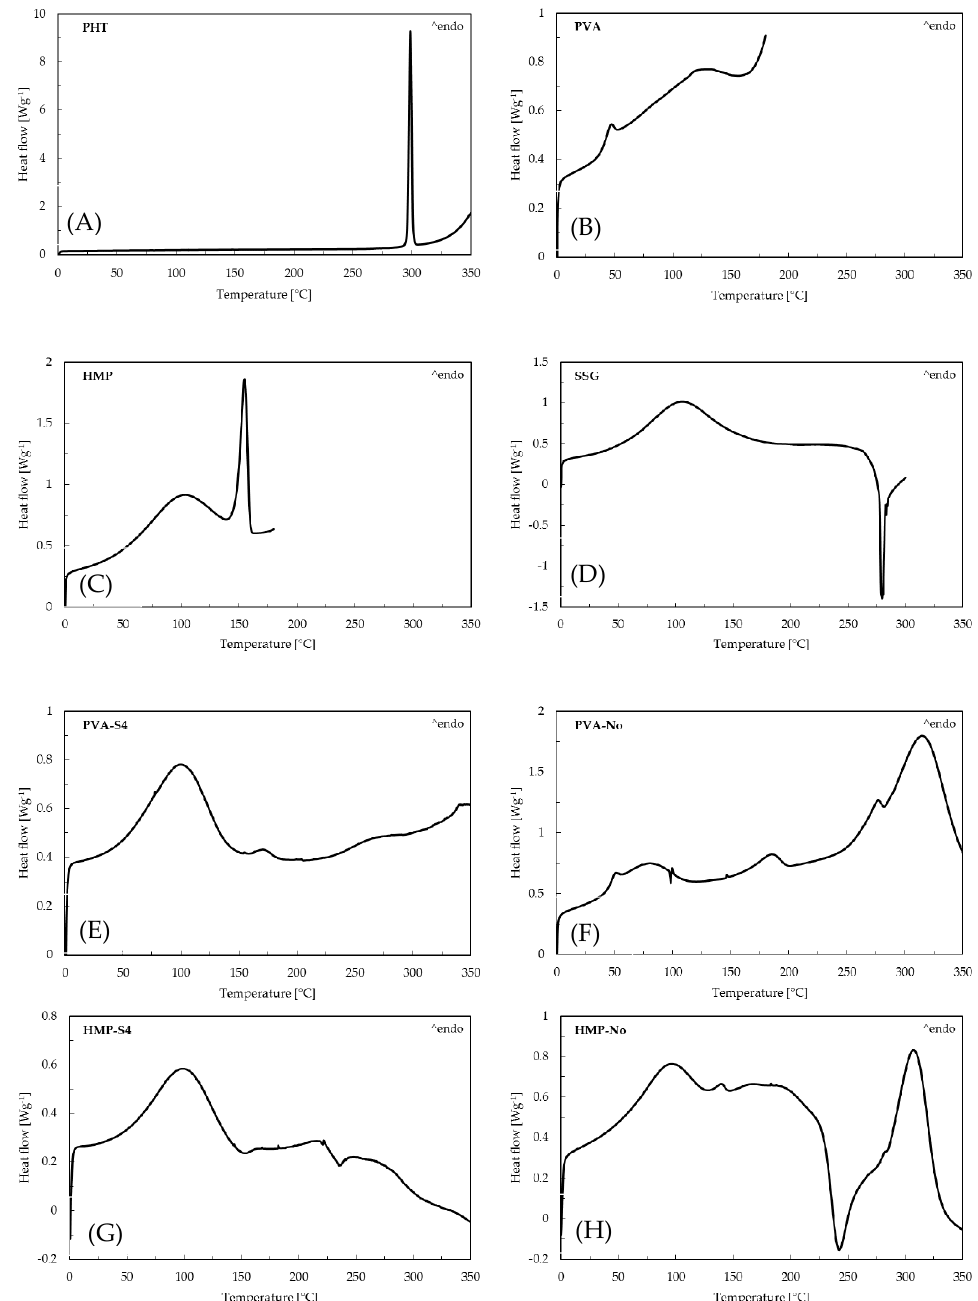
Figure 2. Differential scanning calorimetry (DSC) curves of ( A ) pure drug phenytoin, ( B ) PVA, ( C ) HMP, ( D ) SSG, ( E ) PVA-S4, ( F ) PVA-No, ( G ) HMP-S4 and ( H ) HMP-No ODFs.